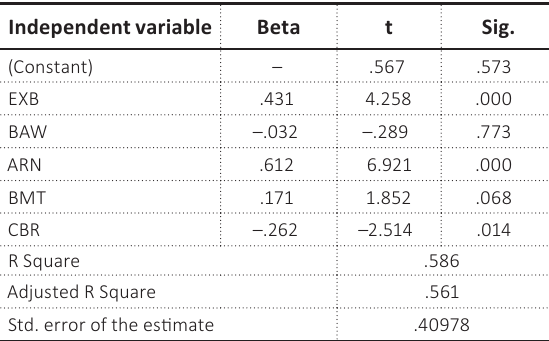
Table 6. Summary of regression results